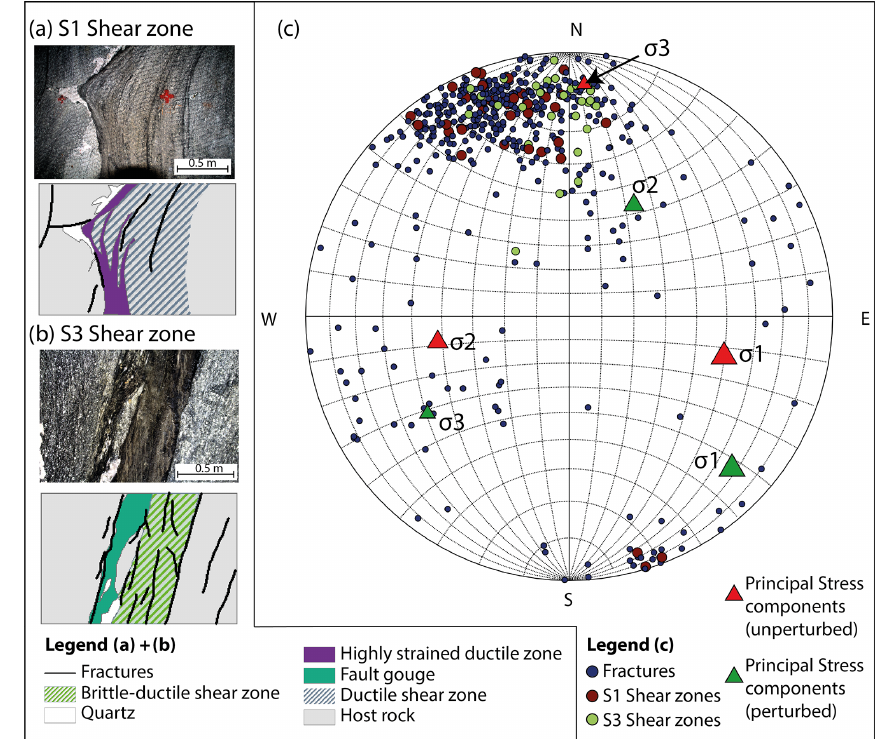
Figure 2. Photographs (upper image) and interpretations (lower image) of the S1 (a) and S3 (b) shear zones as seen at the AU tunnel wall (modified after Krietsch et al., 2018b). (c) A lower hemisphere stereo net showing the poles of all mapped fractures and shear zones. The orientations of the principal stress components from the unperturbed and perturbed tensor are also shown.